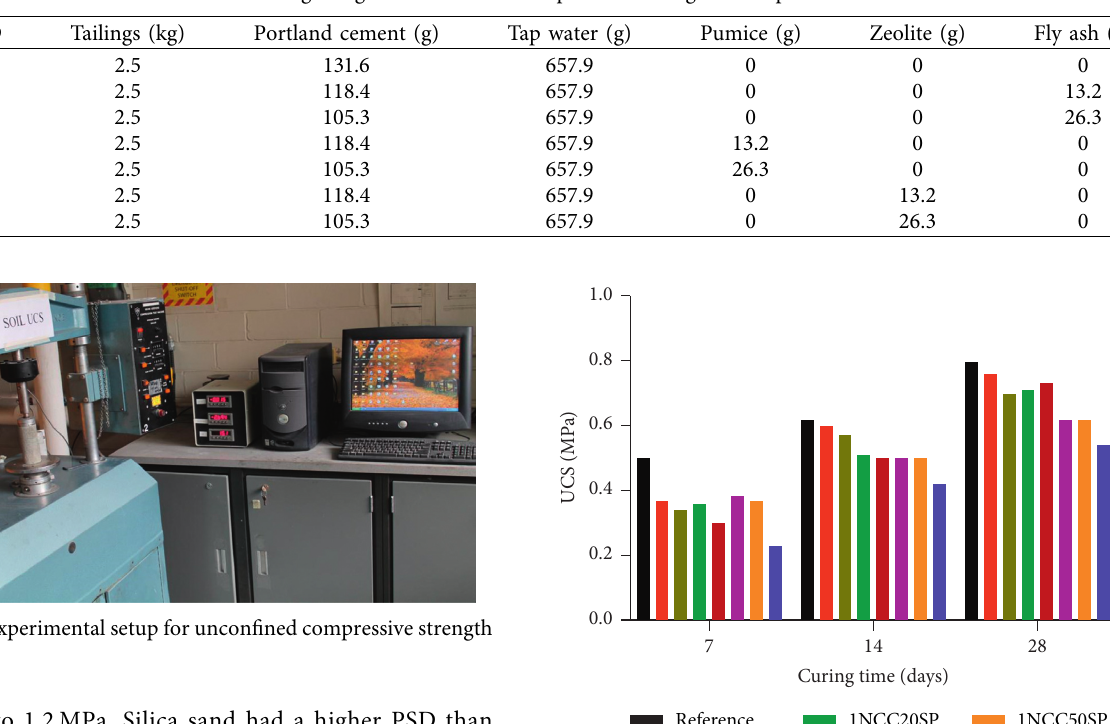
Table 6: Mixing design for all backfill samples containing natural pozzolans.